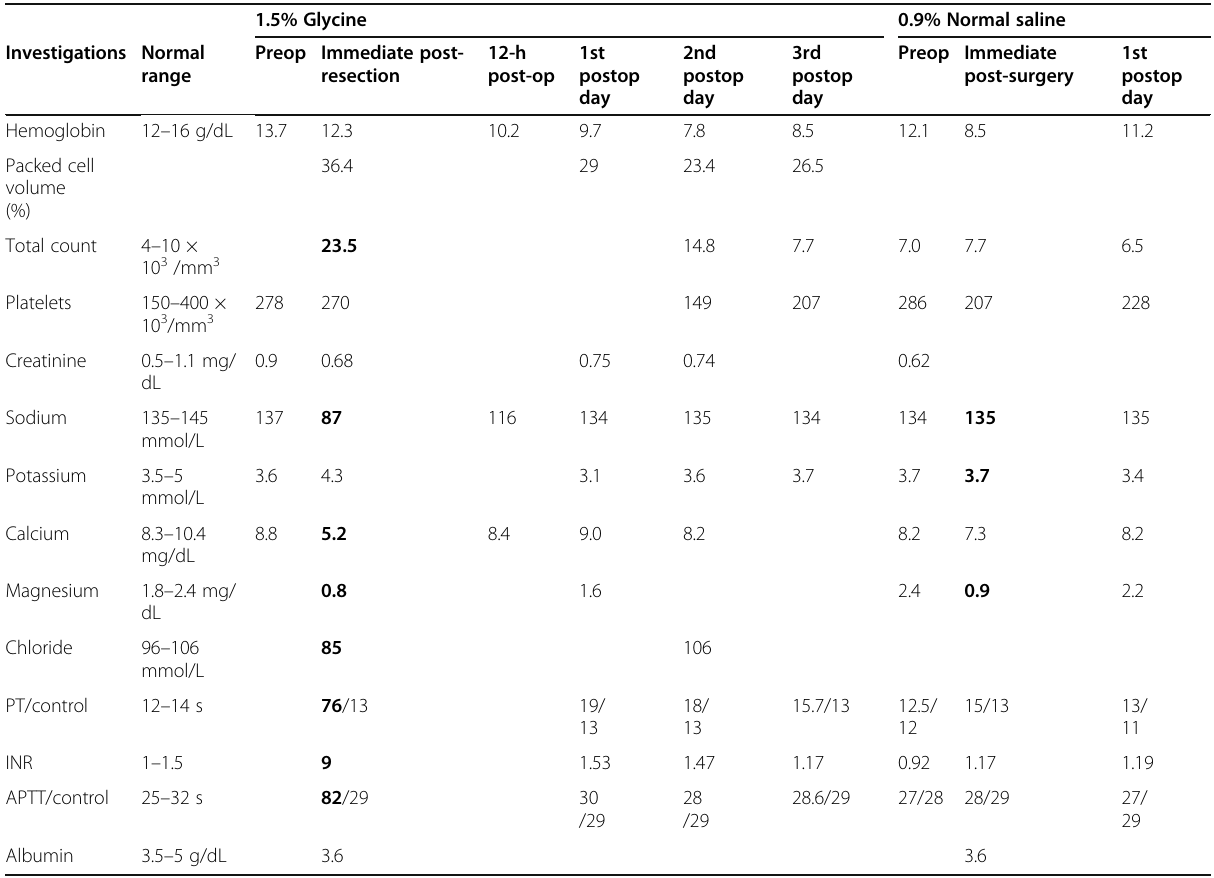
Table 1 Blood investigations following OHIA at phases 1and 2 surgical setting 1.5%